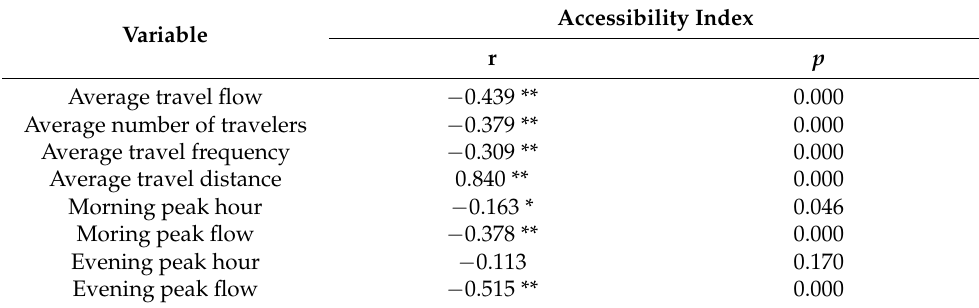
Table 9. Correlation analysis results of resident travel characteristics and accessibility index in 2018.